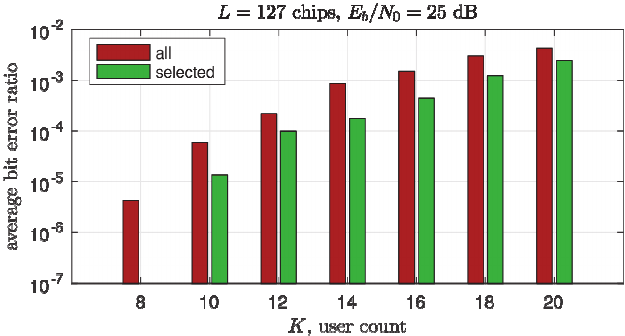
Fig. 13. Asynchronous DS-CDMA: BER levels for selected and all 127-chip- long sequences generated by logistic map at SNR per bit at a level of 25